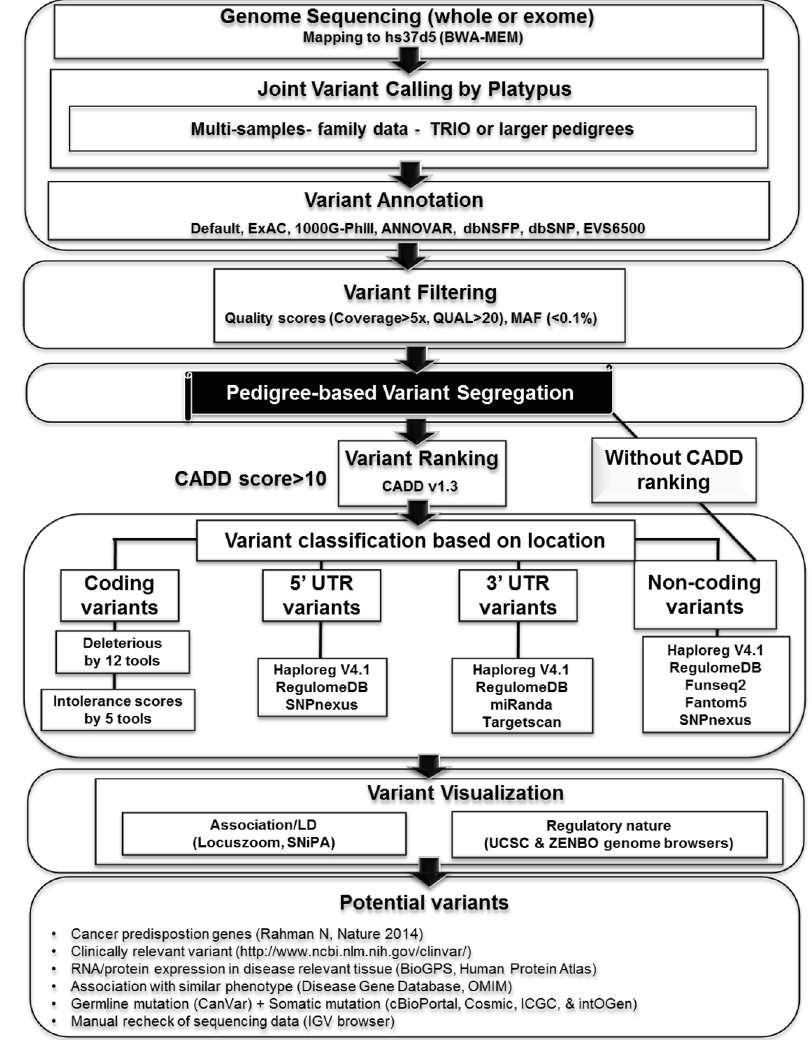
Figure 1. Summary of familial cancer variant prioritization pipeline version 2 (FCVPPv2). This pipeline uses platypus tool 13 for joint variant calling after mapping of the sequencing reads from cases and controls. FCVPPv2 uses several external tools for variant annotation namely ExAC, 1000 Genomes phase III data, ANNOVAR and dbNSFPv3, dbSNP and EVS6500. For candidate variants the variants are filtered using read quality parameters like coverage and quality scores (QUAL) must be > 5 and > 20, respectively. Minor allele frequency (MAF) must be below 0.1% in the European populations in all used databases. Furthermore, these variants are screened with respective to family-pedigree and this is the most critical step in the germline genomics (shown in black shade). After this step, variants are ranked with the help of CADD v1.3 20 and any variants with CADD PHRED score of > 10 belongs to top 10% for probable functional and deleterious variants in the human genome. These deleterious variants are subsequently divided into 4 different categories based on their locations. The coding variants are considered deleterious based on the consensus from 12 deleteriousness prediction tools and 5 intolerance scores. Variants in the 5 ′ UTR are considered regulatory based on the Haploreg V4.1 21 , RegulomeDB 22 and SNPnexus 9 while variants in the 3 ′ UTR are regulatory if supported by the presence of miRNA binding site using Miranda 7 and Targetscan 7.0 8 tools and additional hints are received from Haploreg V4.1 21 and RegulomeDB 22 . For variants in the non-coding segments we combined several state-of- the-art tools such as chromHMM, Segway, FunSeq2 and FANTOM5 data. Non-coding (intergenic and intronic) variants may not always have CADD > 10 even though they will have regulatory implications, so we analyzed all non-coding variants after pedigree segmentation, either with or without CADD > 10. Putative deleterious or regulatory variants are visualized using Locuszoom, SniPA and UCSC genome browser. Potential variants are also checked with sets of additional features, e.g. list of known CPGs 1 and clinically relevant variants (ClinVar), expression data and somatic mutations. We also checked the sequencing data of all cases and controls in a particular family for correctness using the IGV